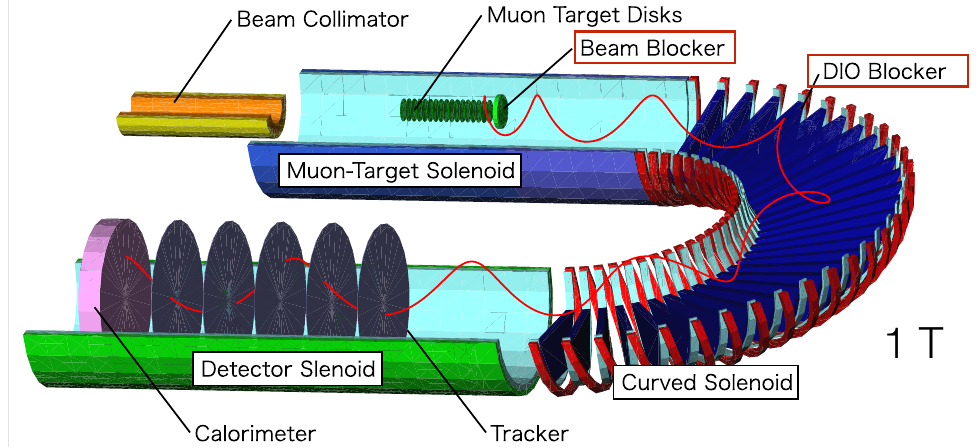
Figure 6. Schematic layout of the downstream section of the Phase-II setup, which includes the muon Figure 1: Beam blocker and DIO blocker. stopping target, the Electron Spectrometer Solenoid, and the Detector Solenoid. Figure 6.13: Cut view of COMET detector. Red rings around the curved solenoid section are magnet coils, and tilted to produce the compensation field (A field that cancels the drift for a 105 MeV electron)